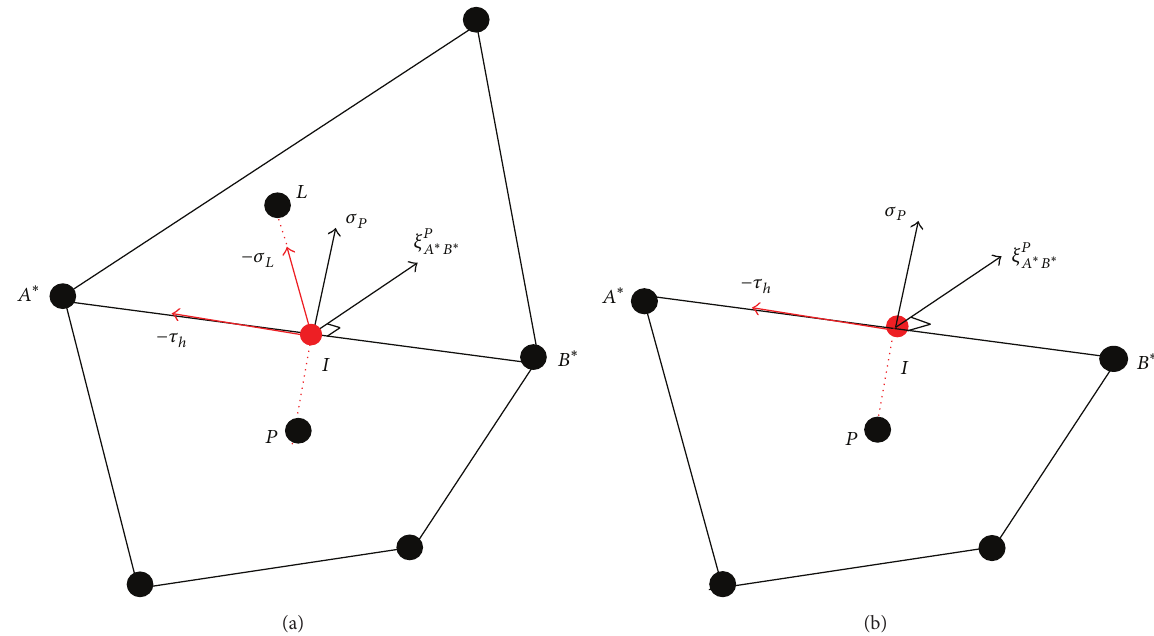
Figure 3: Two molecules for a finite volume computation of the flux across the edge [𝐴 ∗ 𝐵 ∗ ] . (a) The edge [𝐴 ∗ 𝐵 ∗ ] is lying inside the domain Ω . (b) The edge [𝐴 ∗ 𝐵 ∗ ] is part of the boundary of Ω